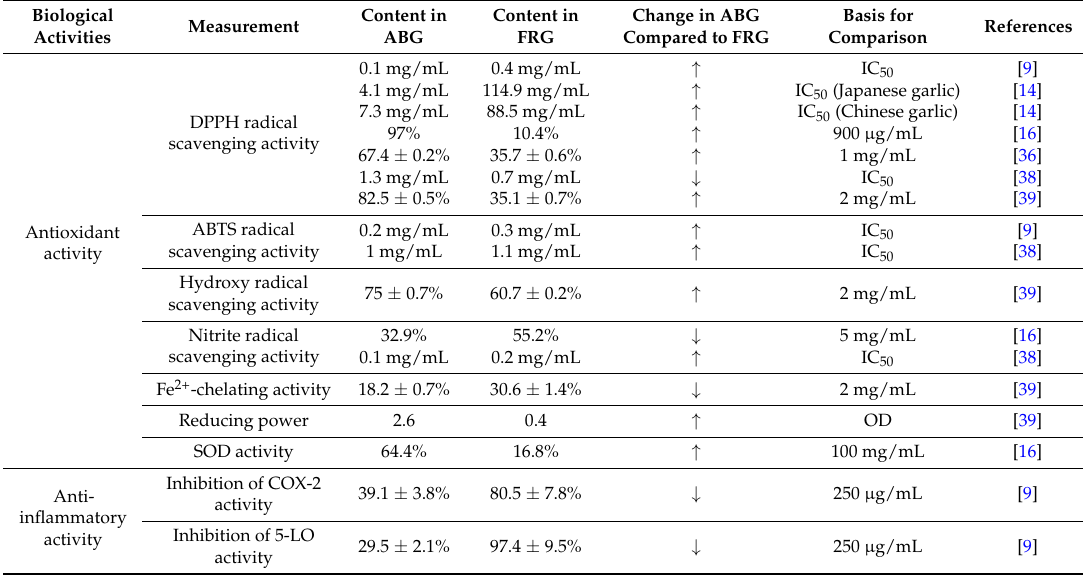
Table 4. Comparison of antioxidant and anti-inflammatory activities between ABG and